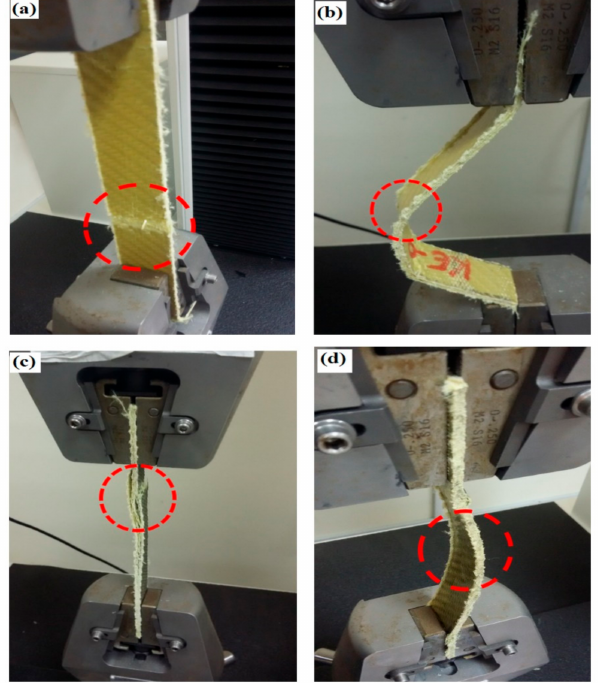
Figure 9. Mechanical testing: ( a ) Kevlar-reinforced epoxy under tension, ( b ) Kevlar-reinforced epoxy under compression, ( c ) Kevlar/epoxy MWCNTs (0.5 wt.%), and ( d ) Kevlar/epoxy